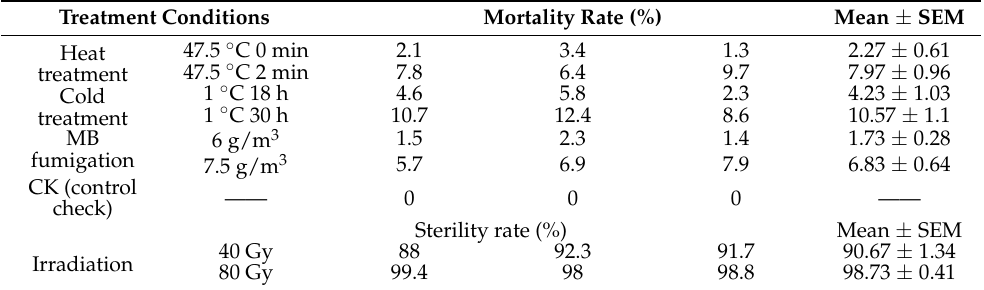
Table 2. Mortality and sterility rate of B. dorsalis third-instar larvae after different phytosanitary treatments. Treatment